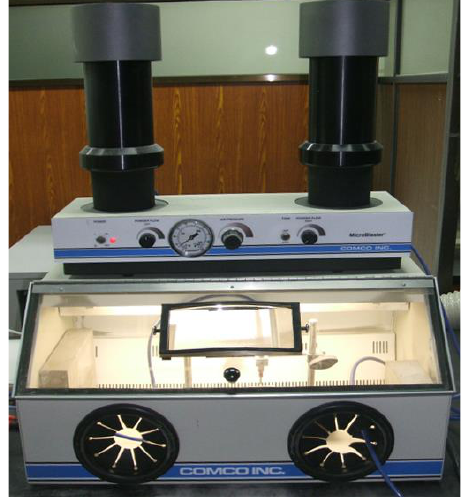
Figure 2. Micro-abrasive jet blaster.